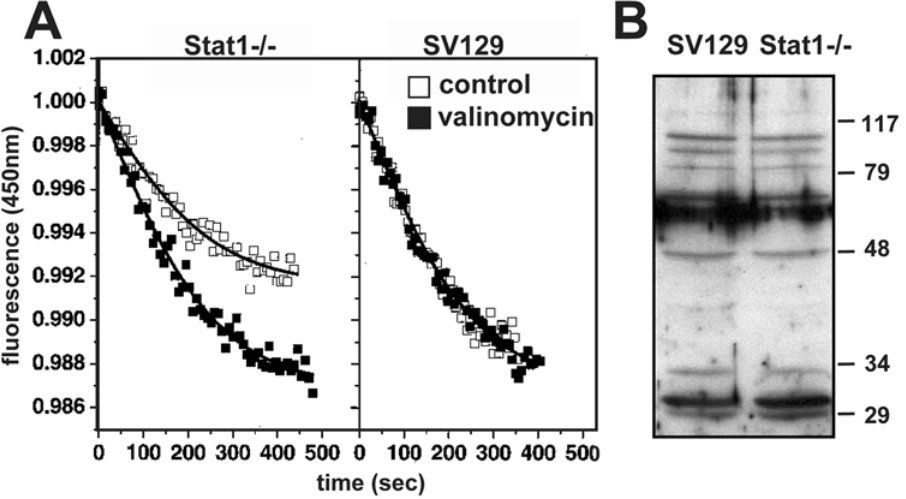
Figure 6. Analysis of vesicle acidification by acridine orange fluorescent quenching. (A) Membrane vesicles derived from phagosomes of Stat1-deficient BMMs and control were diluted into the appropriate reaction mixture containing 2.5 mM ATP, and reactions were started by the addition of 1 mM MgSO 4 either in the absence (control, open squares) or in the presence of 0.1 m M valinomycin (closed squares). All experiments were corrected for base-line drift ( , 5% of total fluorescence). (B) Crude cell extracts were subjected to Western Blot analysis with anti-chloride channel antibody AB656.